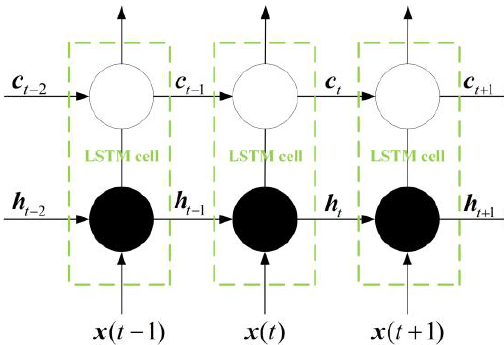
Figure 3. Traditional RNN structure diagram.